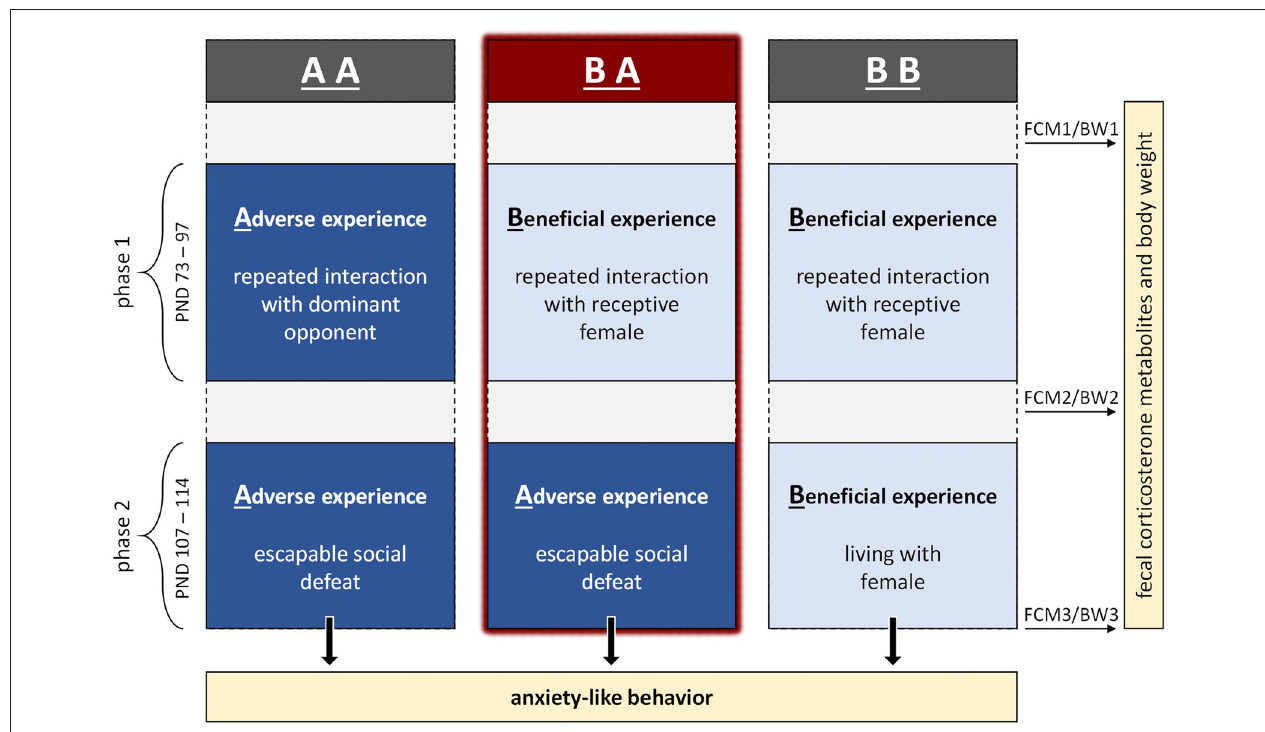
FIGURE 1 | Experimental design. The experiment comprised two phases in adulthood, referred to as phase 1 and 2, during which male mice were provided with either adverse or beneficial social experiences. We compared mice having experienced benefits followed by escapable adversity (BA group) to two control groups: one having experienced throughout adverse conditions (AA group) and one having experienced throughout beneficial conditions (BB group). During the end of phase 2, mice were tested in three paradigms assessing anxiety-like behavior (PND 111–113). In addition to the behavioral tests, fecal corticosterone metabolites (FCM) and body weights (BW) were assessed on PND 71 (FCM1/BW1), 100 (FCM2/BW2) and 114